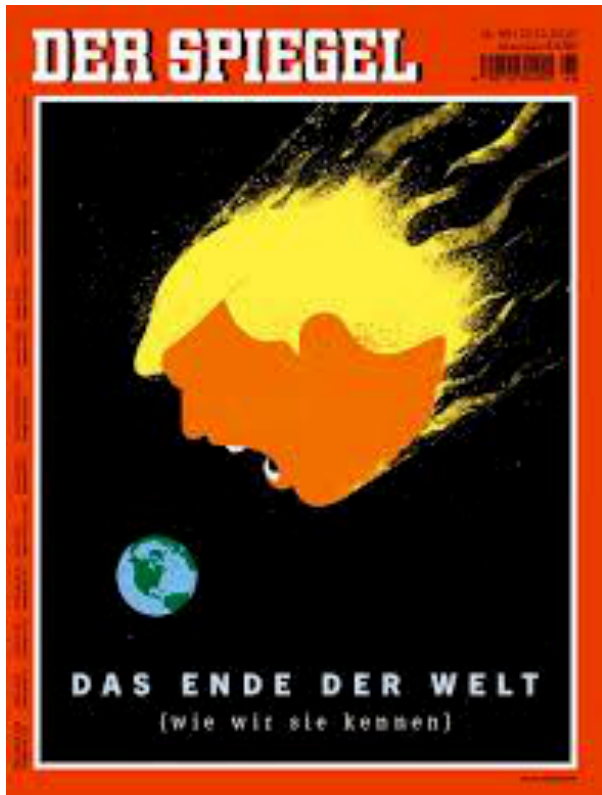
DER SPIEGEL DEPICTING TRUMP AS AN ASTEROID HEADING FOR EARTH COURTESY OF DER